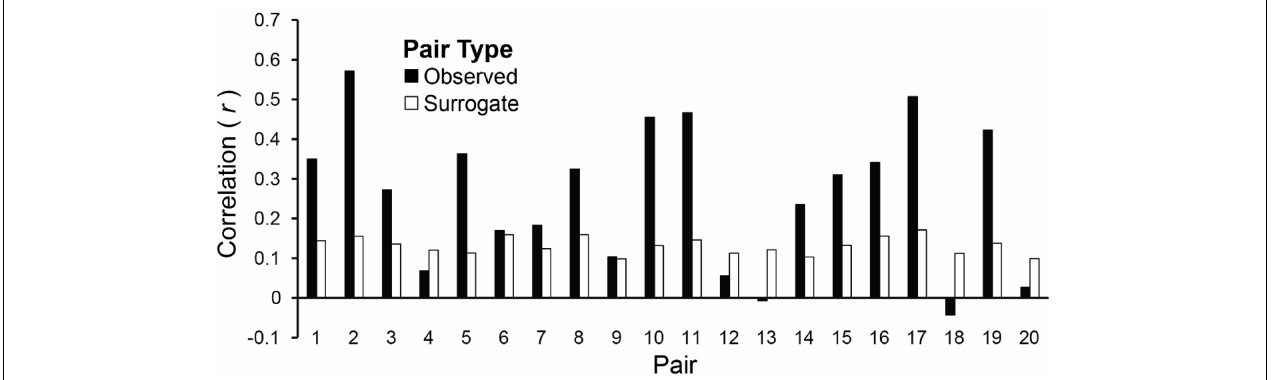
FIGURE 7 | Amplitude envelopes at the Duet performance rate are correlated between duet partners. Mean correlations of duet partners’ mean amplitude fluctuations in spectral energy at the Duet performance rate are shown for each pair, averaged across Duet conditions (black bars). Pairs are ordered by difference in Solo performance rates as shown in Figure 2A (smallest difference at left, largest at right). Mean correlations of surrogate partners’ amplitude envelopes (based on 19 surrogate pairings for each partner with all other partners) are shown for each pair, averaged across Duet conditions (white